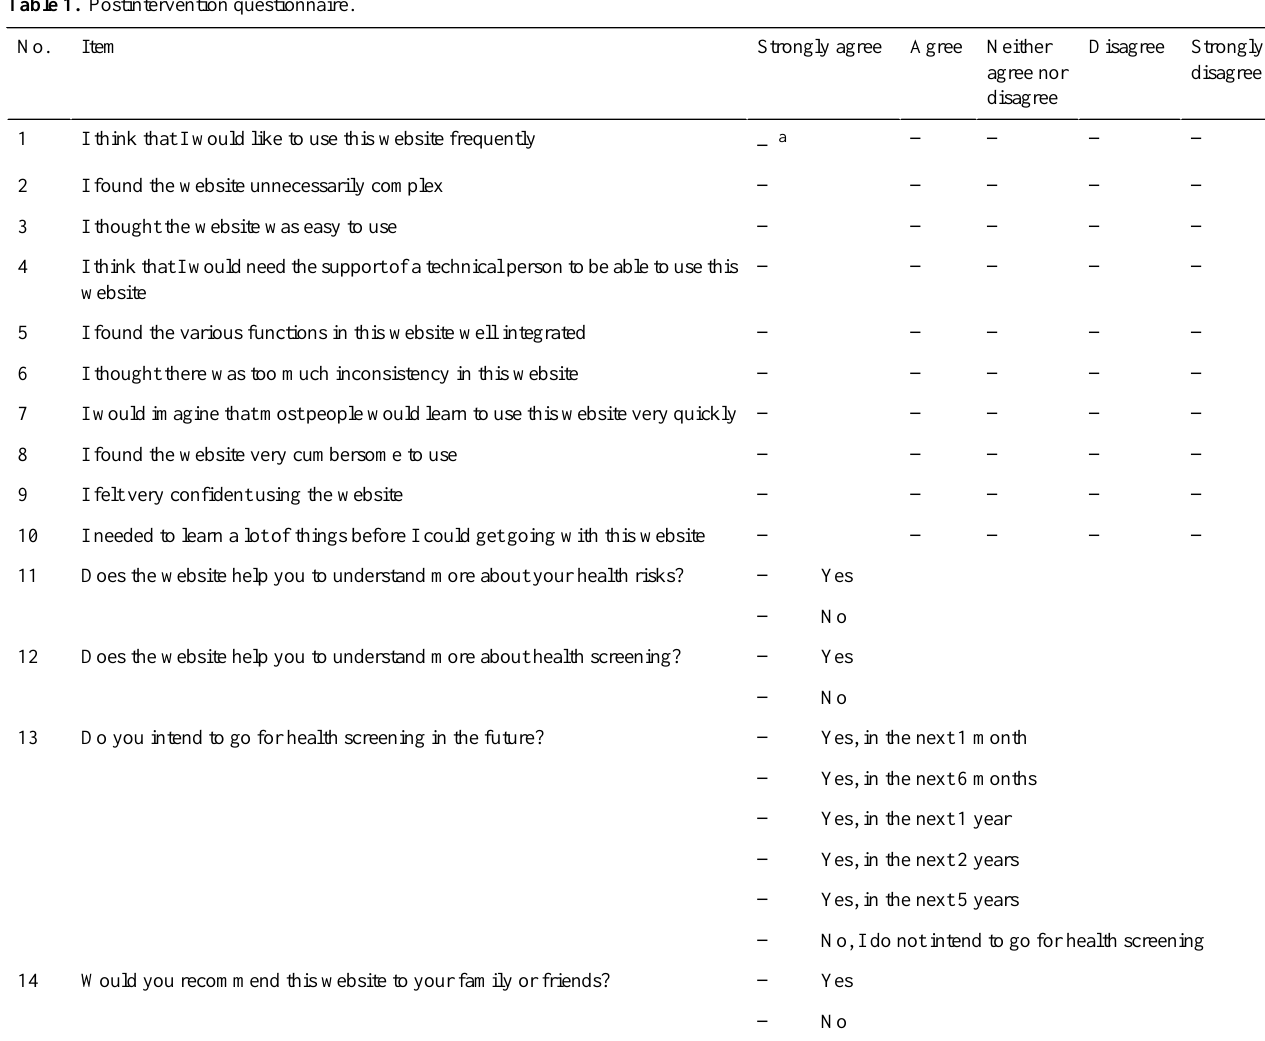
Table 1. Postintervention